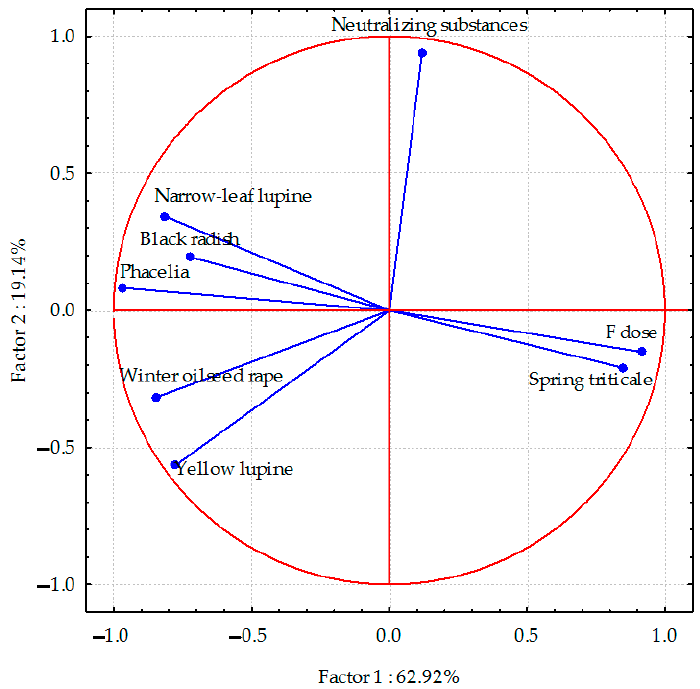
Figure 2. Sodium content in roots of plant species calculated with PCA method. Vectors represent sodium content in roots of plant species versus fluorine dose and neutralizing substances application.